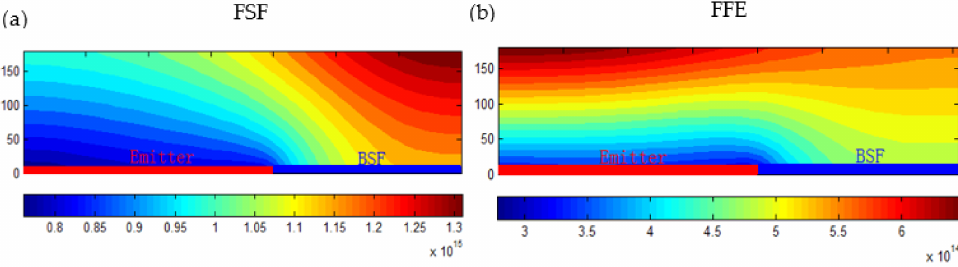
Figure 2. Gradient of the holes density in the simulated IBC cell structures: ( a ) FSF and ( b )